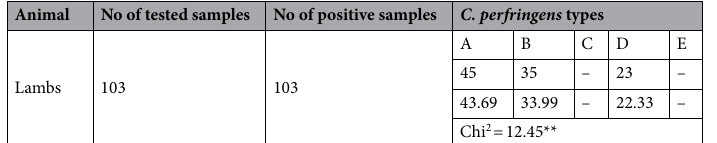
Table 3. C. perfringens’ toxins serotyping using ELISA. ** = Significant at ( P < 0.01).